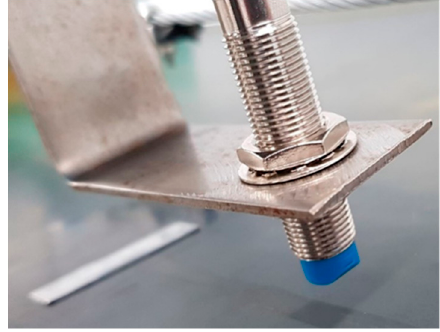
Figure 6. Inductive sensor at the measuring point.